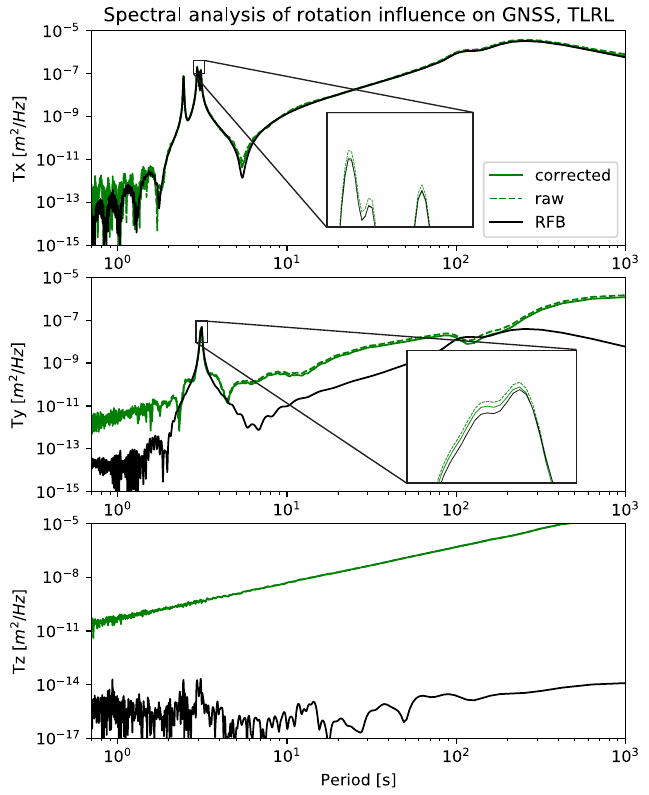
Figure 5. The figure includes three data sets; ‘raw’ is the measured GNSS data in displacement, ‘corrected’ denotes the back rotated GNSS data in displacement; and, ‘RFB’ is the robot feedback. The zoomed-in parts are only shown for the horizontal axes, because the vertical axis of GNSS only shows